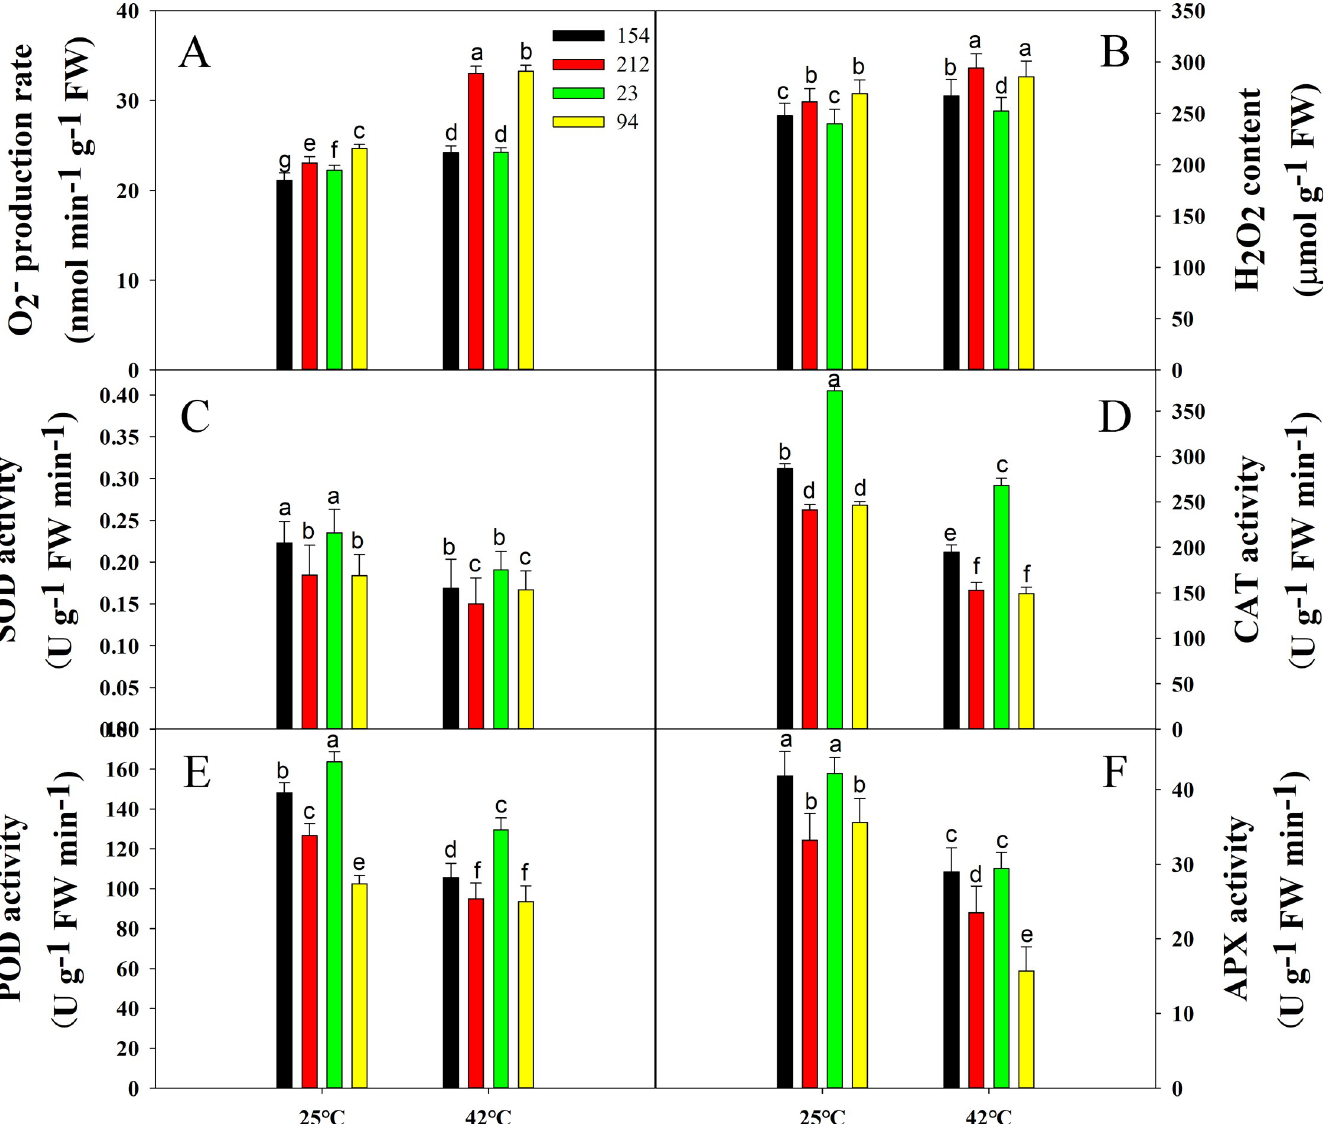
Fig 6. Effects of high temperature (treatment at 42˚C for 4 h) on the contents of (A) O 2 � − and (B) H 2 O 2 and on the activities of antioxidant enzymes (C) SOD, (D) CAT, (E) POD, and (F) APX in flag leaves of wheat. Lines 154 and 23 possess high photosynthetic rates; Lines 212 and 94 possess low photosynthetic rates. Each bar represents the mean ± SE from three independent experiments. Different letters indicate significant differences at P =